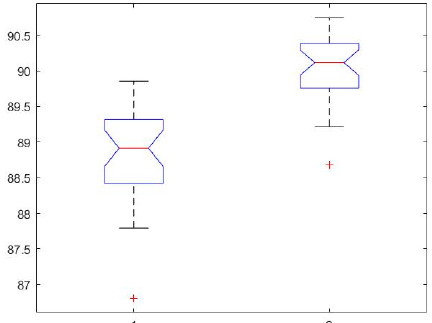
Figure 28. ANOVA test, POCID indicator.